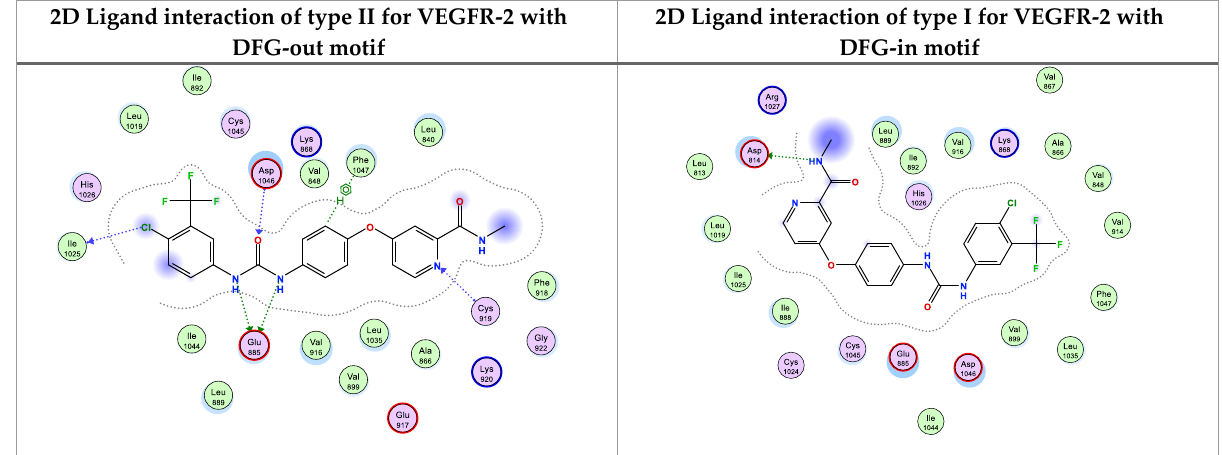
Figure 3. 2D Binding of sorafenib (a reference ligand) with DFG-out and DFG-in motif of type II and I for VEGFR-2, respectively.